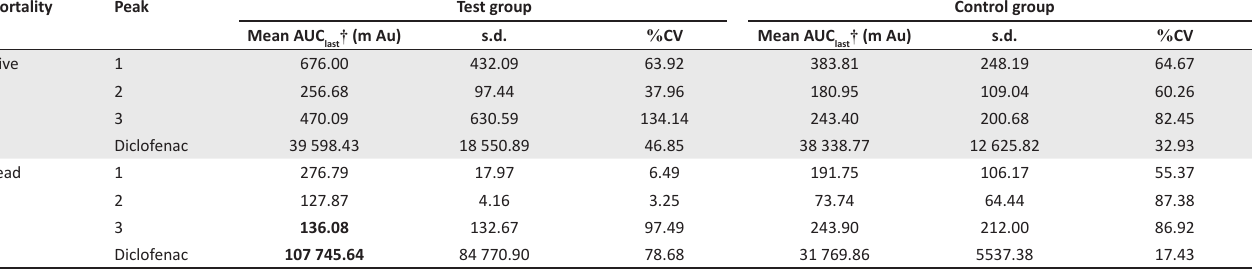
TABLE 2: Mean dose-corrected area under the curve to the last measured (quantifiable) time point values for each metabolite peak and diclofenac per treatment group. Mortality Peak Test group Control